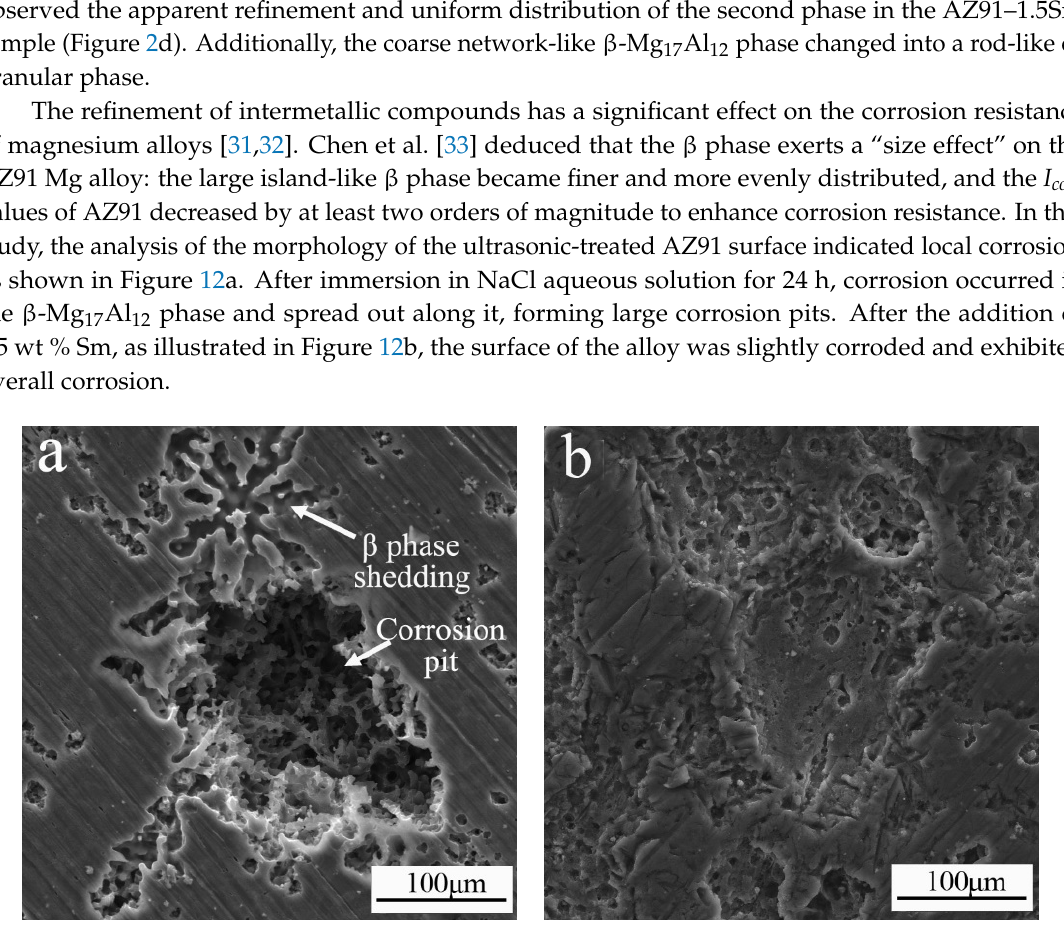
Figure 12. Corrosion morphology of the ultrasonic-treated ( a ) AZ91 alloy and ( b ) AZ91–1.5Sm alloy after immersion in aqueous 3.5 wt % NaCl solution for 24 h.